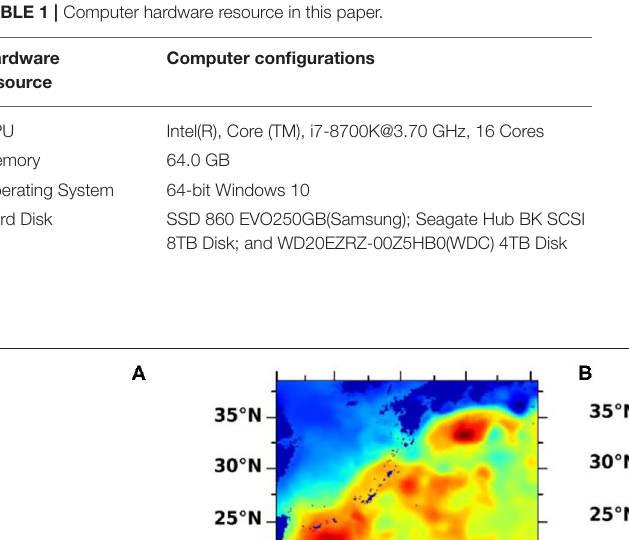
Frontiers in Marine Science |